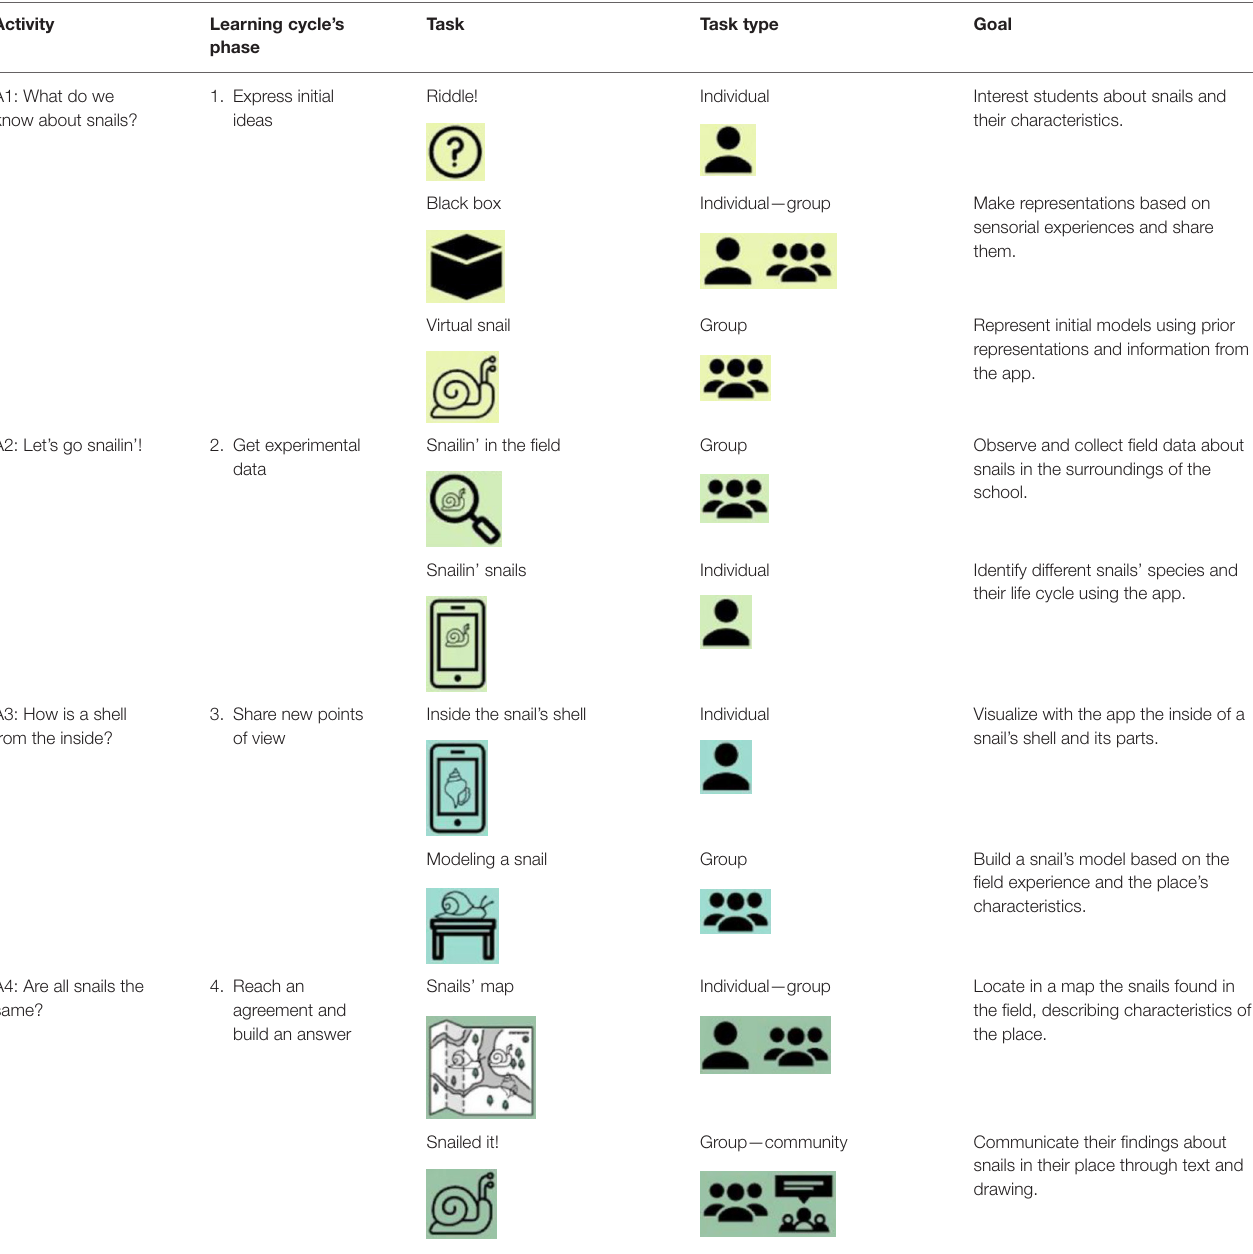
TABLE 3 | A summary of the activities in this